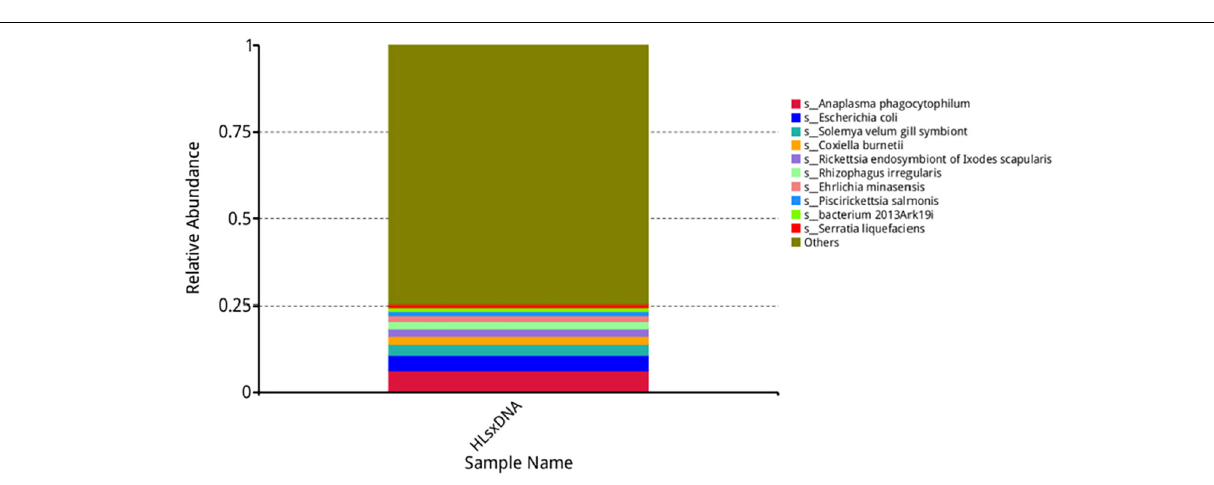
FIGURE 7 | Top 10 most abundant species. The horizontal axis presents the sample names, the vertical axis presents the relative proportion of species annotated to a certain type, and the species corresponding to individual color blocks are indicated in the legend on the